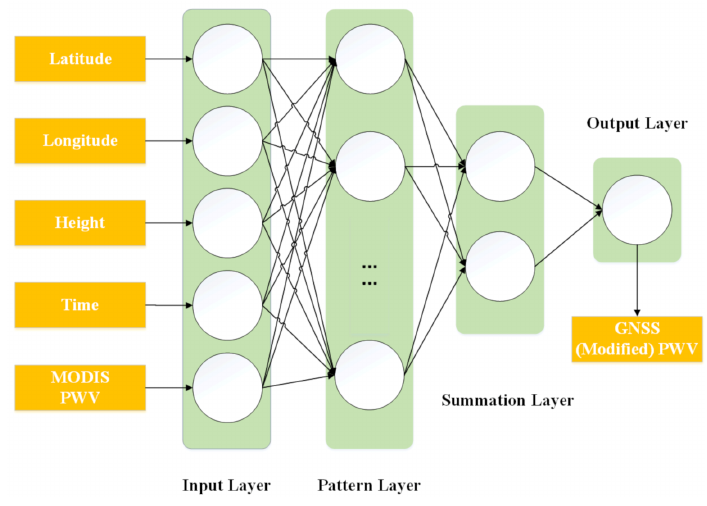
Figure 4. MODIS–GNSS PWV GRNN calibrate